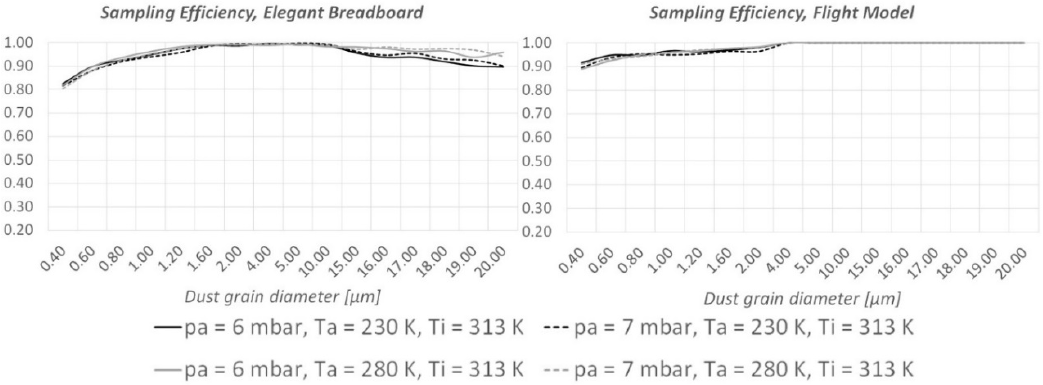
Figure 7. Comparison between the sampling efficiencies of MicroMED’s Elegant Breadboard and Flight Model for “hot instrument conditions” (T i = 313 K) .